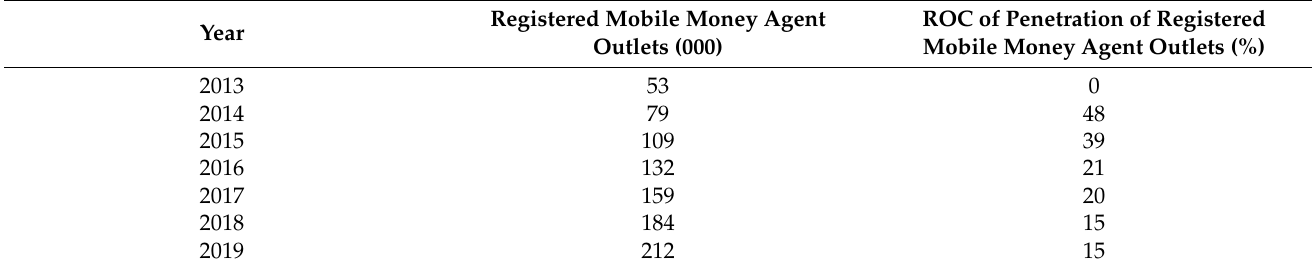
Table 6 . Penetration of mobile money agent outlets. Table 6. Penetration of mobile money agent outlets.